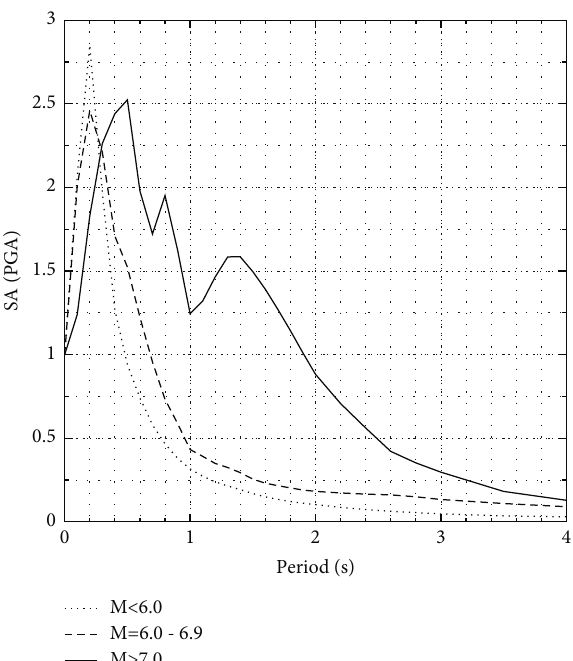
Figure 2: Mean normalised acceleration response spectra as a function of the earthquake magnitude.